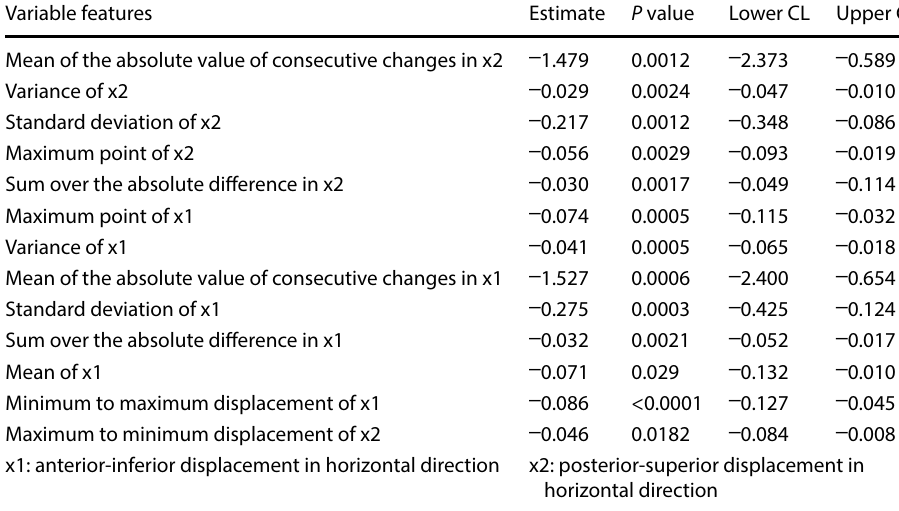
Table 3 Univariate analysis of extracted hyoid bone